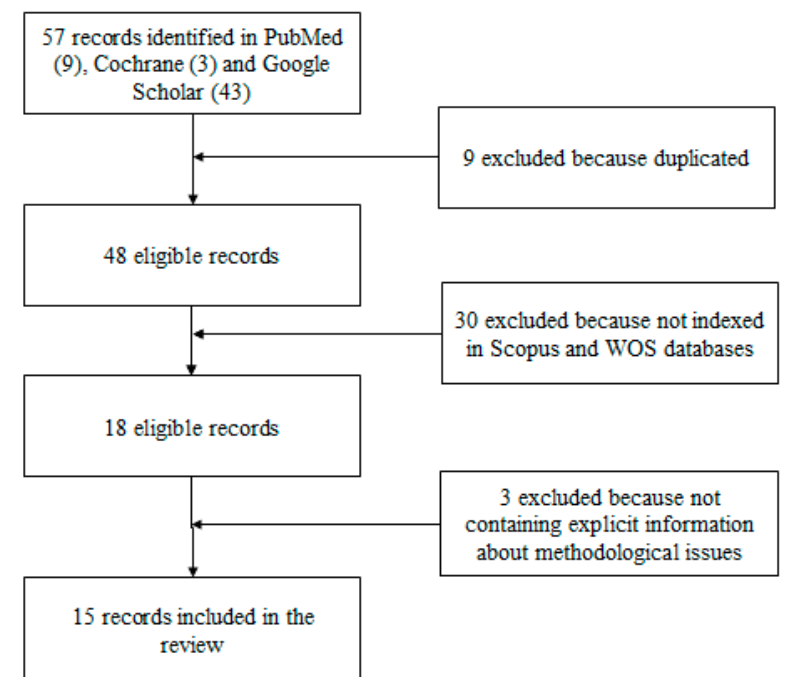
Figure 1. PRISMA (Preferred Reporting Items for Systematic Reviews and Meta-Analyses) process flowchart.